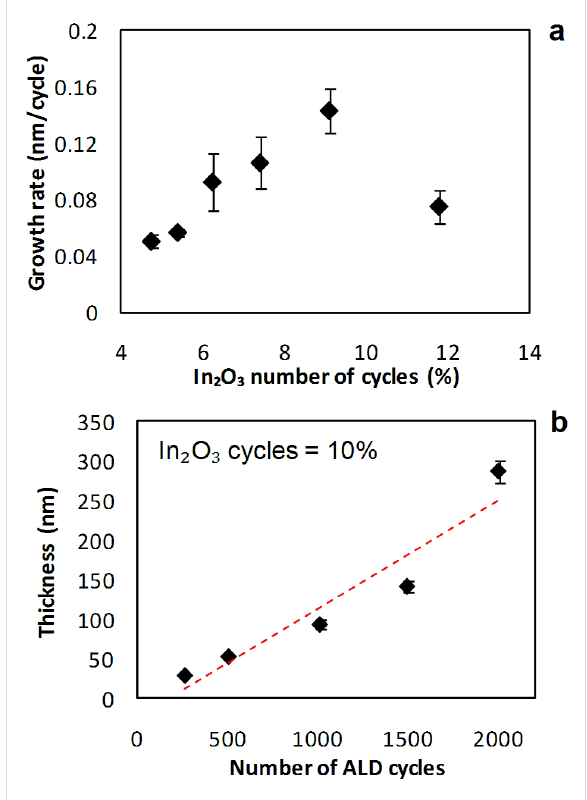
Figure 4: Influence of a) the number of In 2 O 3 cycles on the growth rate b) the number of process cycles on the film thickness when using O 2 plasma as oxygen precursor. The dotted line is a guide to the eyes.